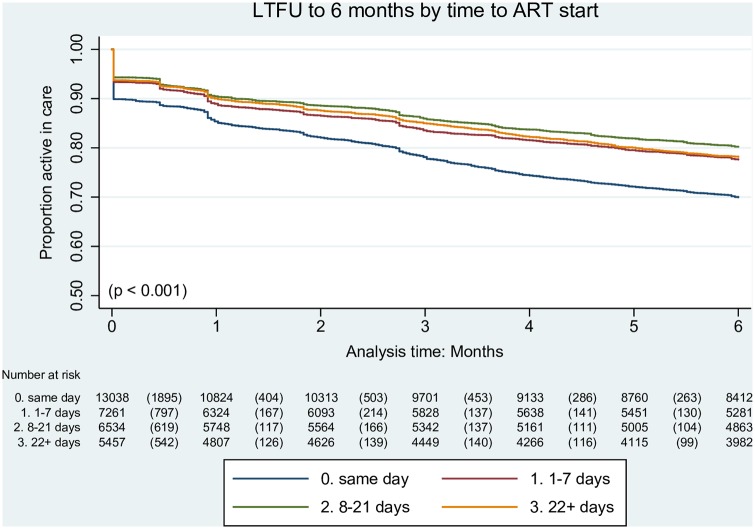
Kaplan-Meier survival curve of LTFU by time from HIV diagnosis to antiretroviral therapy initiation.(p = Peto-Peto test for equality of survivor functions. ART, antiretroviral therapy; HIV, human immunodeficiency virus; LTFU, loss to follow-up).